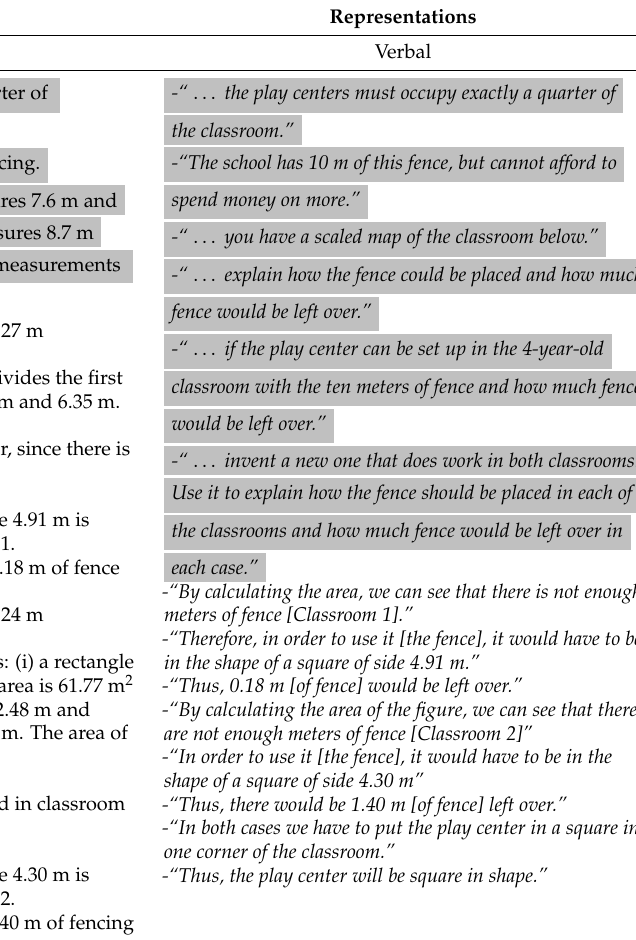
Table 4. Analysis of the written production for the task “the play center.” The elements shaded in gray were explicitly provided in the statement of the task (Source: prepared by the authors). System Mathematization